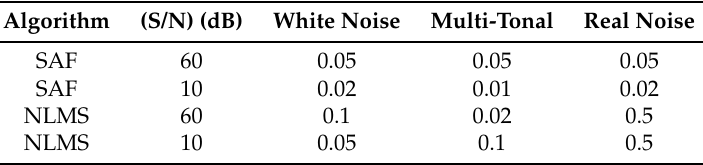
Table 2. Adaptation step size used in test case 1.